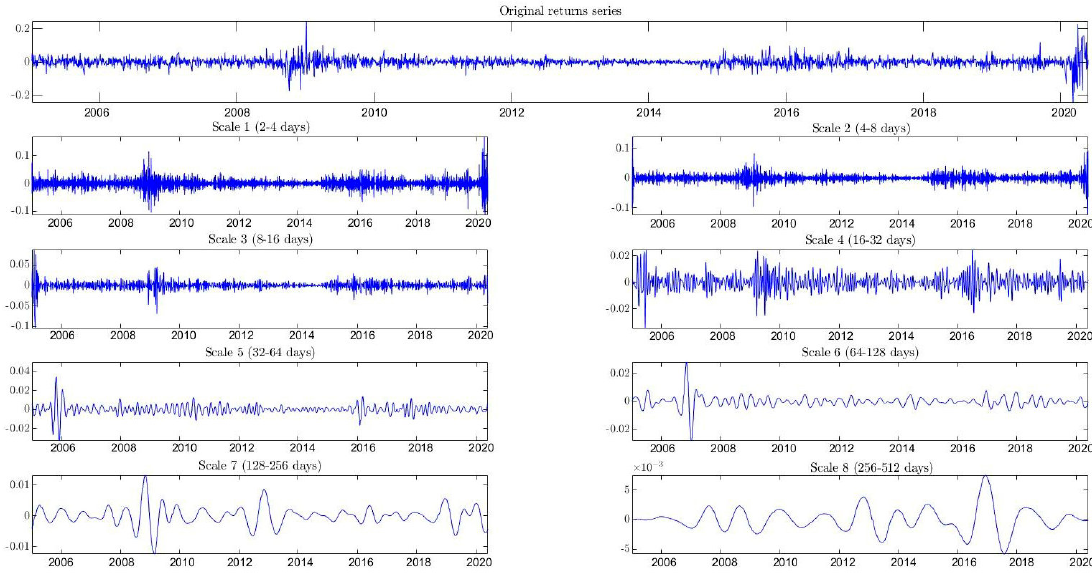
Figure 2. Maximum overlapping discrete wavelet transformation (MODWT) for Brent spot price.